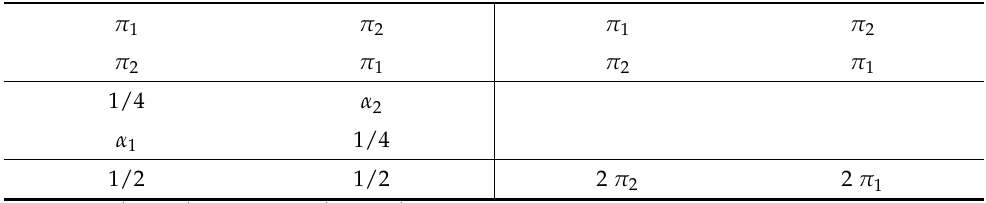
Table A1. G2|G2 method.